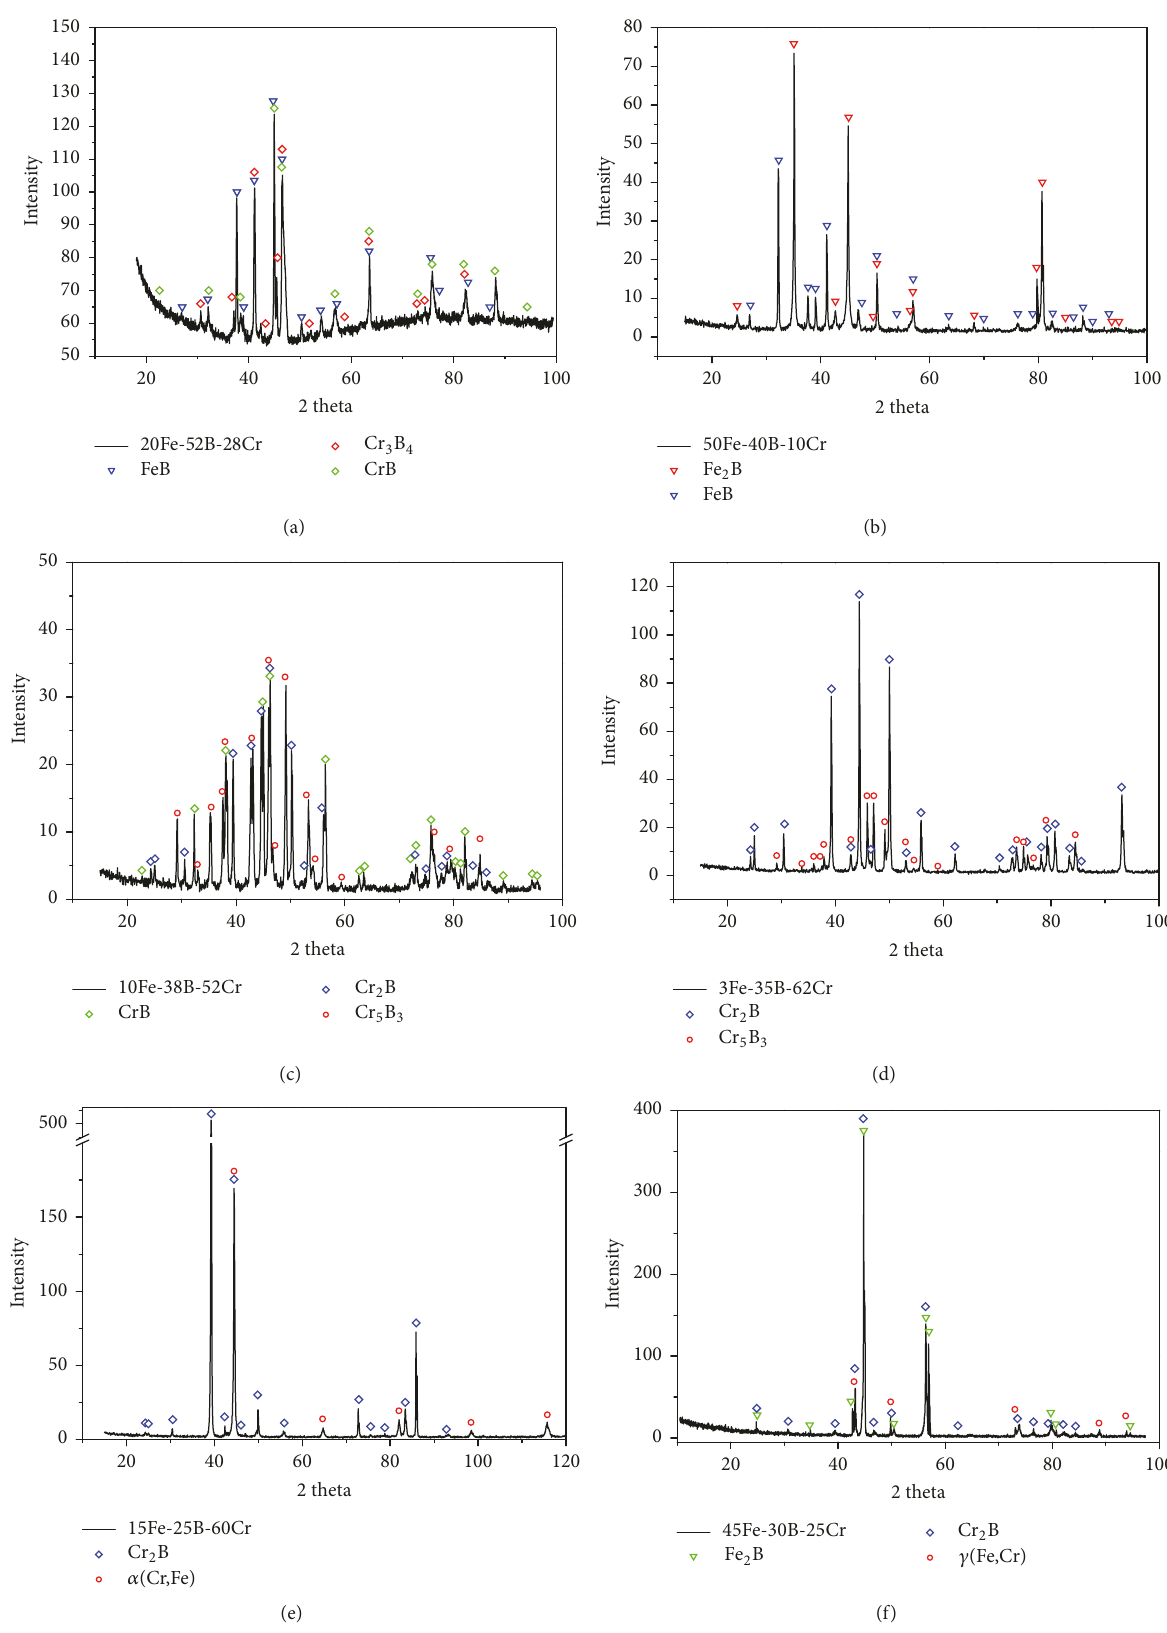
Figure 3: X-ray spectrum of the investigated B-Cr-Fe alloys after annealing at 1353 K: 20Fe-52B-28Cr alloy (a); 50Fe-40B-10Cr alloy (b); 10Fe-38B-52Cr alloy (c); 3Fe-35B-62Cr alloy (d); 15Fe-25B-60Cr alloy (e); 45Fe-30B-25Cr alloy